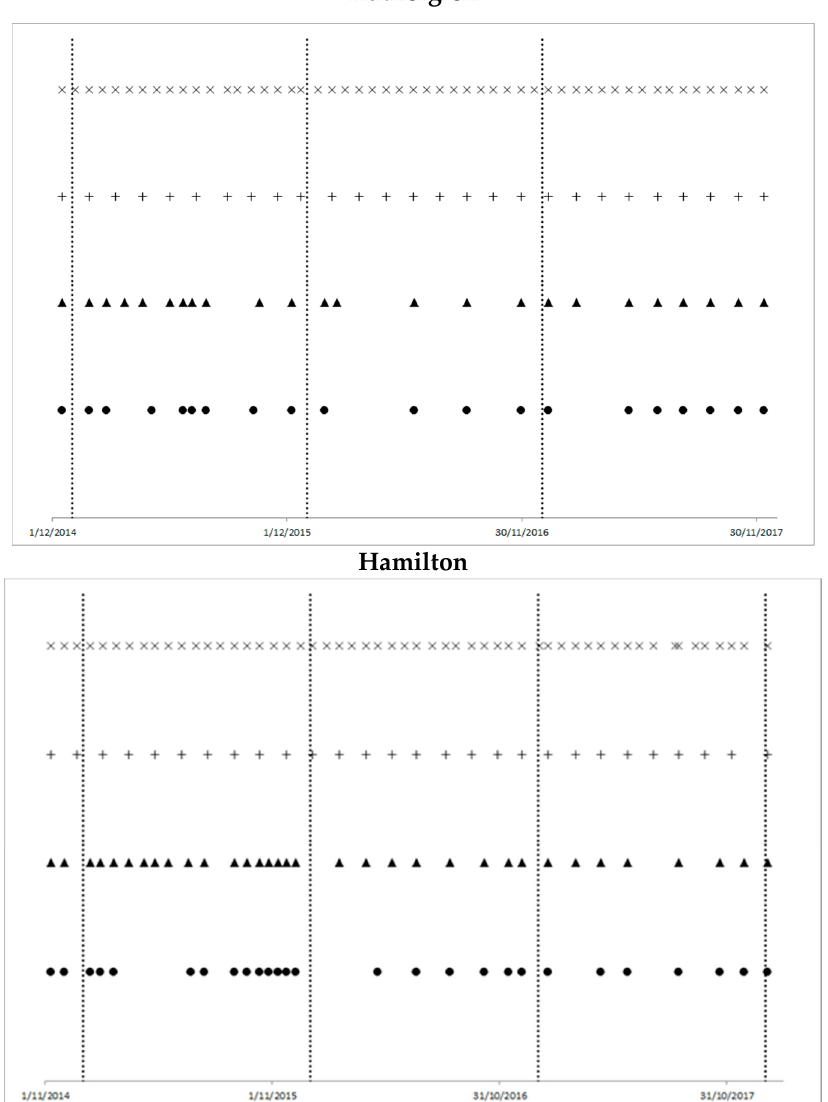
Figure 4. Harvest dates for each defoliation treatment at Rutherglen (Experiment 2) and Hamilton (Experiment 3). Short recovery = ×, Long recovery = +, New shoots = ▴ , New shoots + fl owering = ● . Vertical dotted lines represent start of each calendar year.